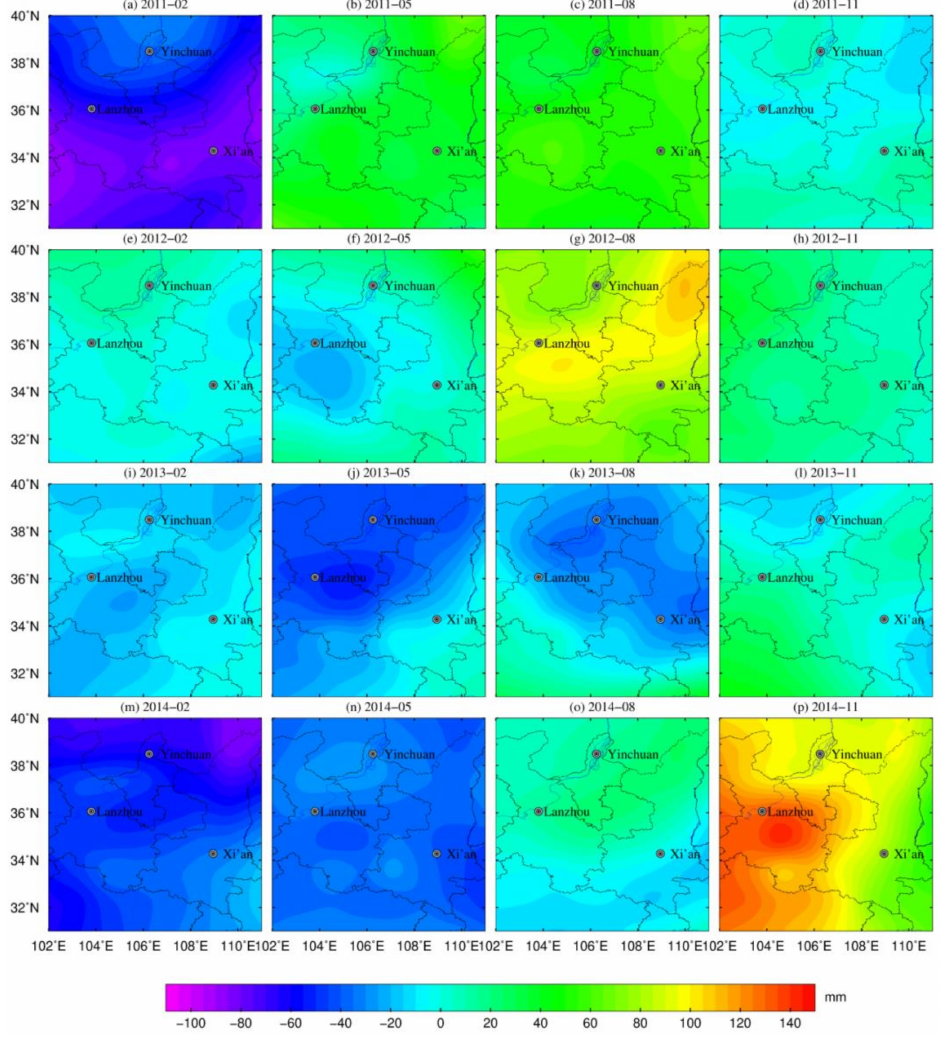
Figure 14. Spatiotemporal distribution of regional GWS change from 2011 to 2014 derived from the fusion method depending on GNSS and GRACE